Question: Condense the content of this figure into a single sentence.
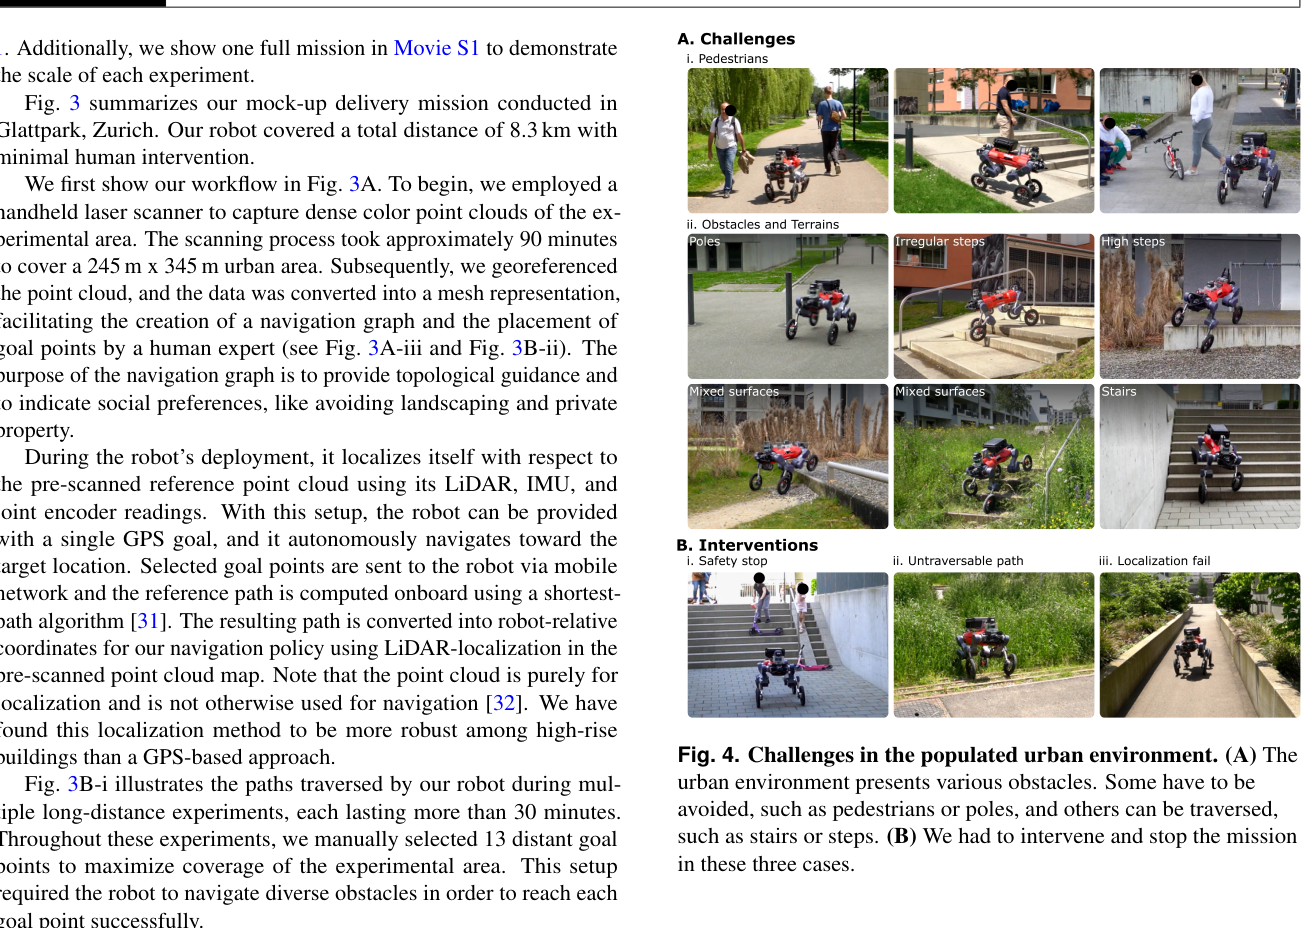
Answer: Challenges in the populated urban environment. (A) The urban environment presents various obstacles. Some have to be avoided, such as pedestrians or poles, and others can be traversed, such as stairs or steps. (B) We had to intervene and stop the mission in these three cases.